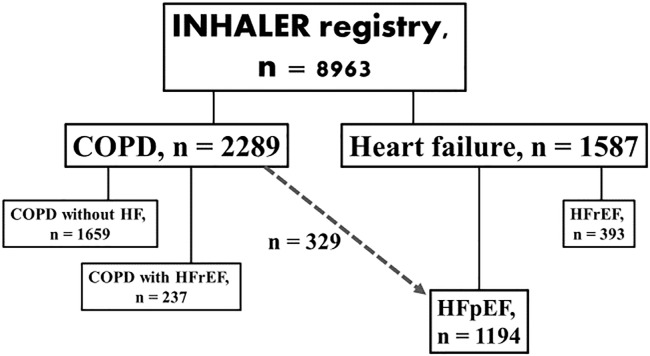
The flow chart of the study population.